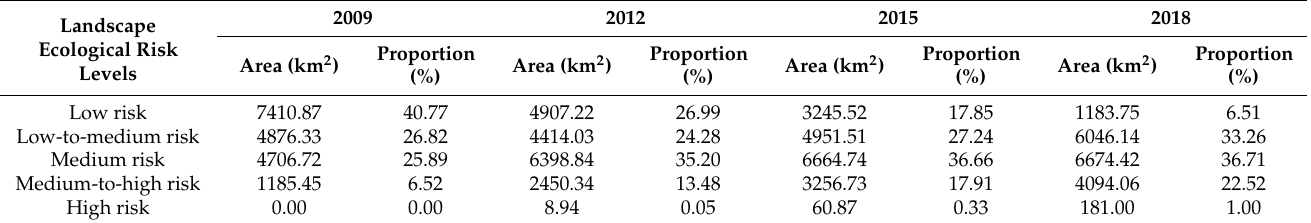
Table 9. Changes in Landscape Ecological Risk Levels in Changde from 2009 to 2018.